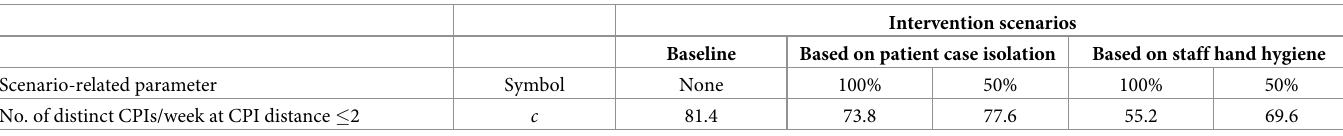
Table 5. Scenario-related